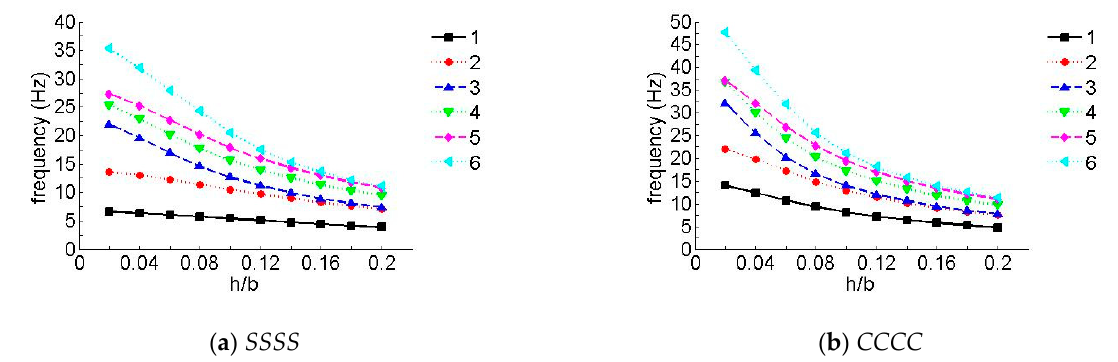
Figure 6. Natural frequency parameters for a laminate with an arbitrary ratio between thickness and width (three layers). ( a ) SSSS, ( b ) CCCC.